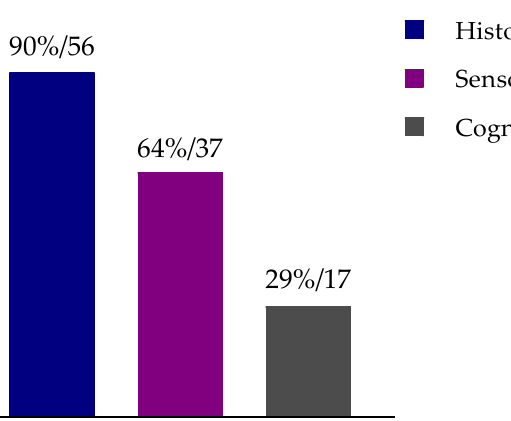
Figure 3. Studies that included histological, cognitive function, and/or sensorimotor function evaluation after stem cell therapy in animal models for hypoxic-ischemic encephalopathy (percentage/number of reports).